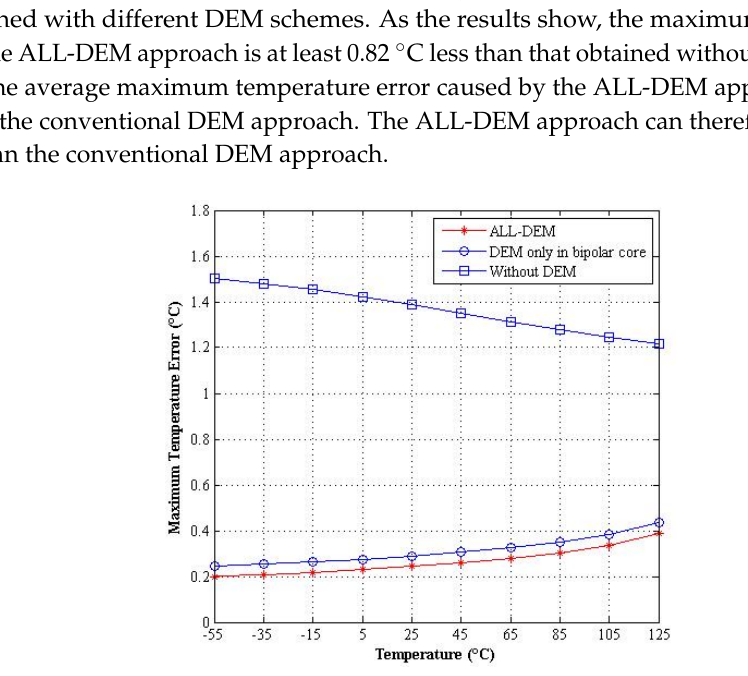
Figure 4. Maximum temperature errors simulations with different dynamic element matching (DEM) schemes.